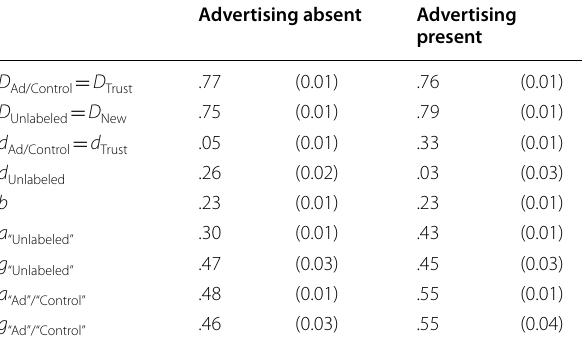
Table 3 Parameter estimates for statement recognition, source memory, and guessing as a function of advertising presence (absent, present) in Experiment 3 Advertising